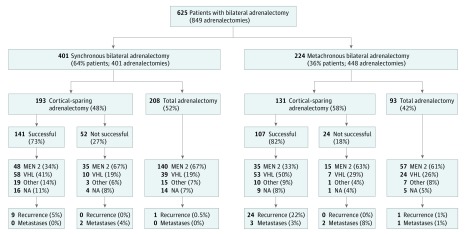
Schema for Bilateral Pheochromocytoma Registrants, Their Operations, and Steroid-Dependent vs Steroid-Independent OutcomesMEN 2 indicates patients with medullary thyroid carcinoma plus pheochromocytoma and/or patients with a RET mutation; VHL, pheochromocytoma with hemangioblastoma of eyes or central nervous system and/or patients with a VHL mutation; other, patients with a mutation in one of the genes SDHD, SDHB, MAX, or TMEM127 or signs of neurofibromatosis type 1 or clinically familial pheochromocytomas.